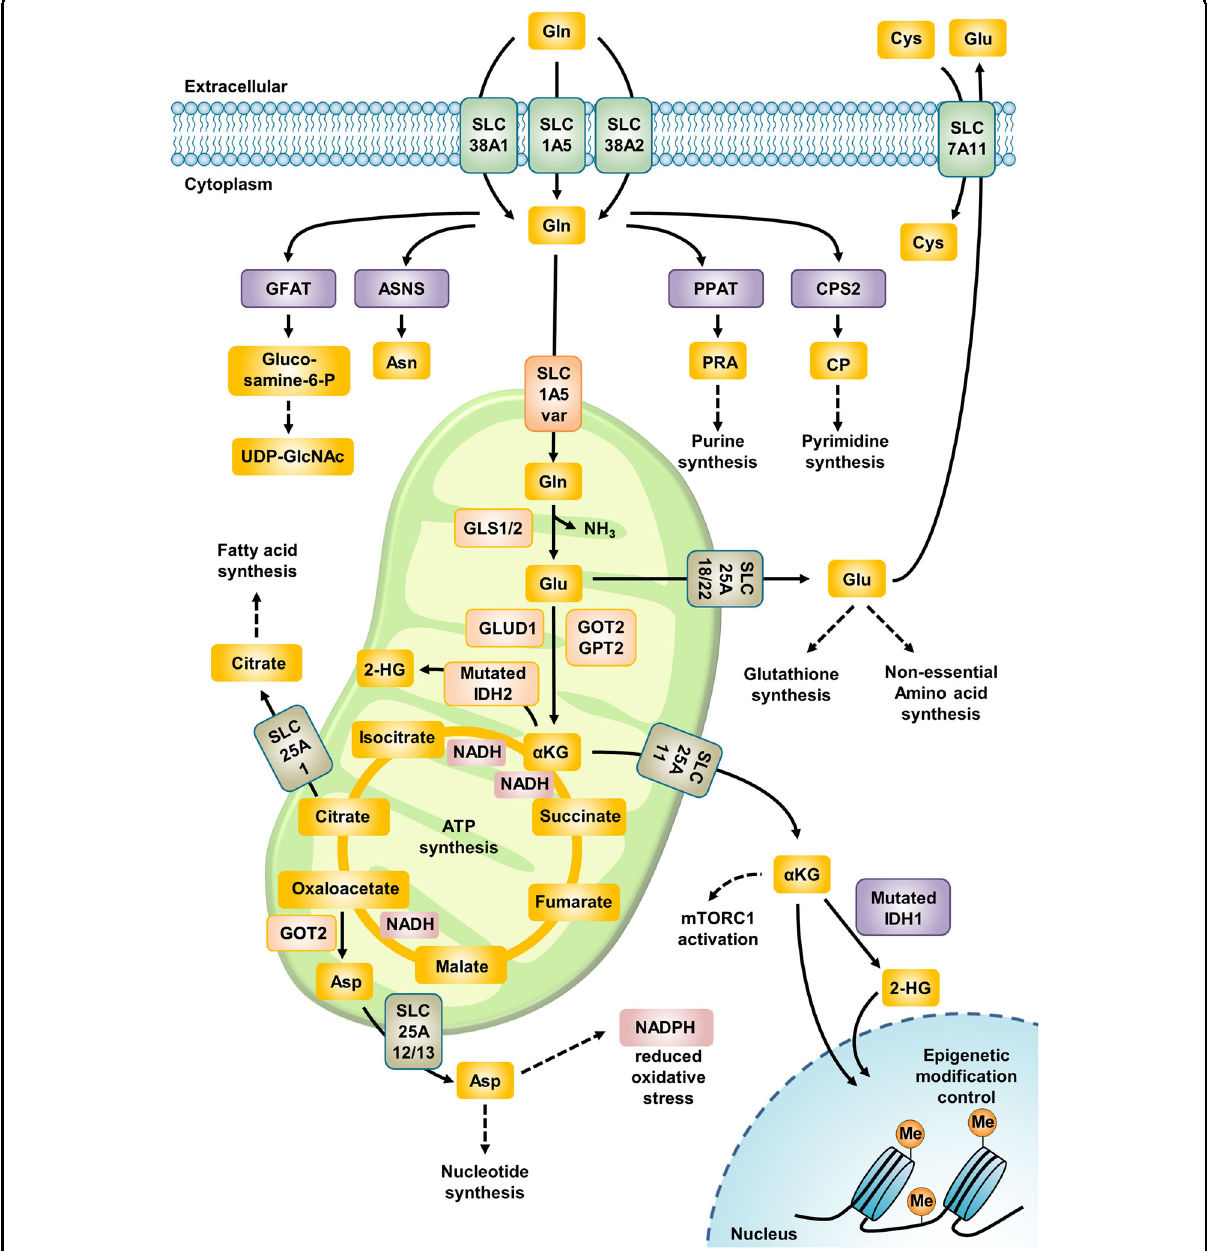
Fig. 1 Glutamine metabolic pathways. Glutamine enters through several plasma membrane glutamine transporters and is then utilized in the cytosol in processes such as the biosynthesis of nucleotides, asparagine, and UDP-GlcNAc. For glutaminolysis, glutamine is transported into the mitochondrial matrix through the SLC1A5 variant and subsequently converted to glutamate by GLS. Next, GLUD1 or several aminotransferases catalyze the deamidation of glutamate, producing α -KG. Glutamine-derived α -KG supplies metabolites for the TCA cycle and fuels the generation of 2-HG under conditions of IDH2 mutation or hypoxia. Citrate derived from glutamine via reductive carboxylation supports fatty acid synthesis under conditions of hypoxia or HIF-2 α transcription factor stabilization. Glutamine-derived α -KG also activates the mTORC1 pathway. Α -KG and 2-HG affect epigenetic modi fi cation through α -KG-dependent dioxygenases. Gln glutamine, Glu glutamate, Asn asparagine, Cys cystine, Asp aspartate, α KG α - ketoglutarate, PRA 5-phosphoribosyl-1-amine, CP carbamoyl phosphate, GFAT glutamine-fructose-6-phosphate transaminase, ASNS asparagine synthetase, PPAT phosphoribosyl pyrophosphate amidotransferase, CPS carbamoyl phosphate synthetase, GLS glutaminase, GLUD glutamate dehydrogenase, GOT glutamic-oxaloacetic transaminase, GPT glutamic-pyruvate transaminase, IDH isocitrate dehydrogenase, 2-HG 2- hydroxyglutarate, Me